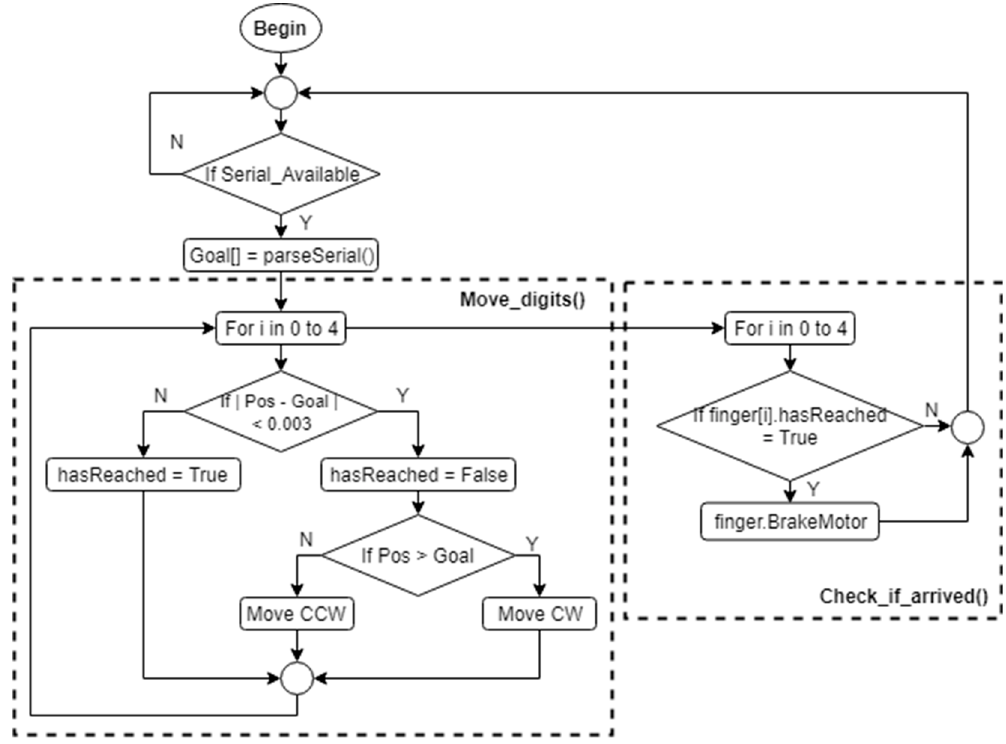
Figure 8. Control algorithm flow chart.